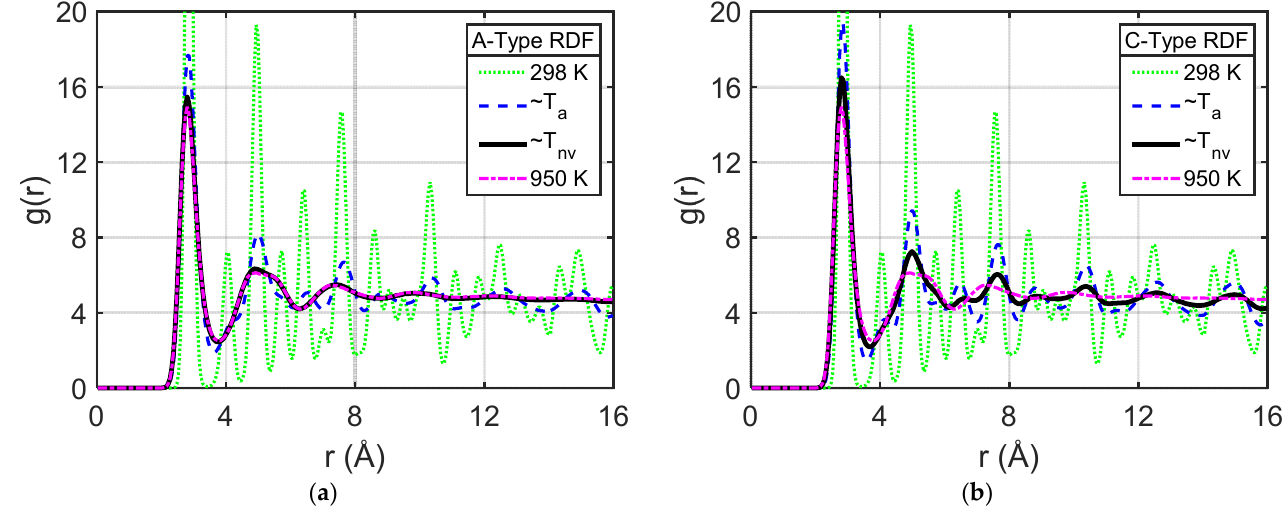
Figure 8. Radial distribution function (RDF) curves of the Al shell at four different temperatures for cases with a 30% core volume fraction and a 0.5 Kps − 1 heating rate in ( a ) the A-type and ( b ) the C-type: 298 K, ~T a , ~T nv , and 950 K (exceeds the melting point); all cases have relatively the same RDF curves at their own T a but not at T nv .